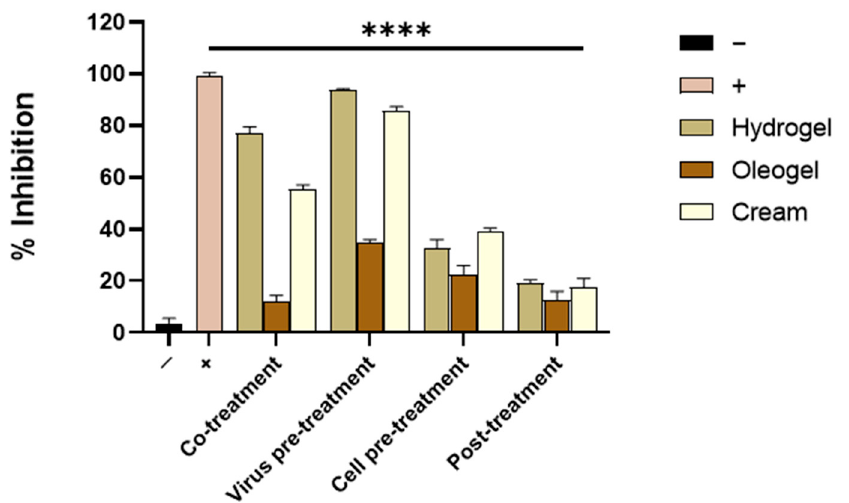
Figure 9. Antiviral activity of OFE formulations against HSV ‐ 1. Different assays were performed in order to evaluate anti-HSV-1 activity. Hydrogel and cream formulations interfered with the early stages of infection, acting in co-treatment and virus pre-treatment assays, although they did not exhibit any relevant antiviral activity either in cell pre ‐ treatment or post ‐ treatment tests. Statistical analyses were determined by ANOVA with Dunnett’s test for multiple comparisons. Significances are referred to as the negative control (–). **** p < 0.0001.